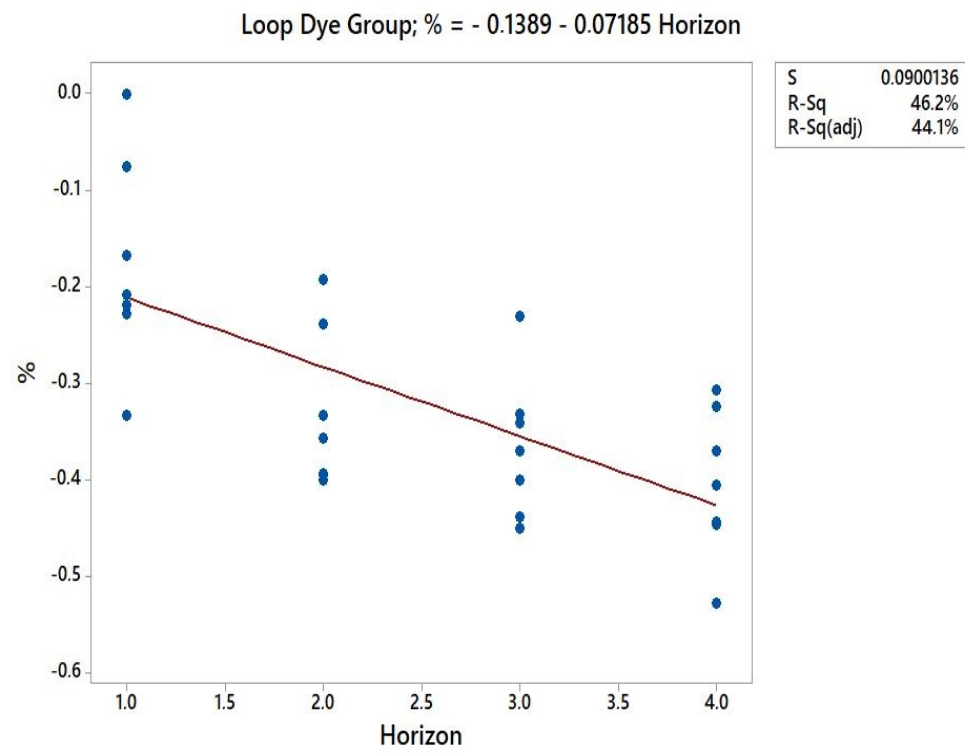
Scheme 2. Simple Linear Regression.